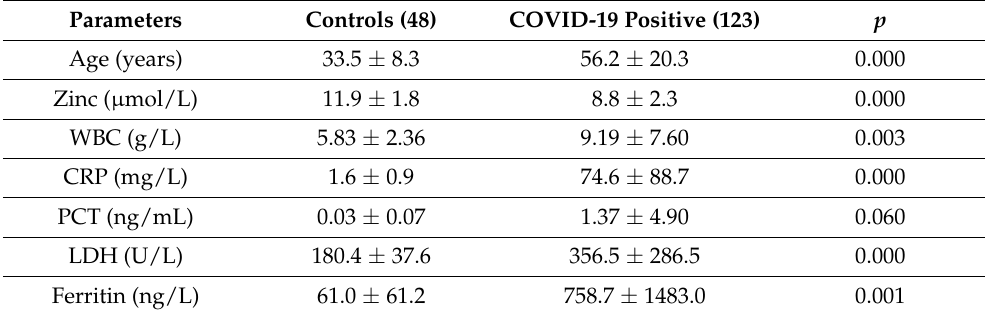
Table 1. Demographic and laboratory parameters of control subjects and combined COVID-19- positive